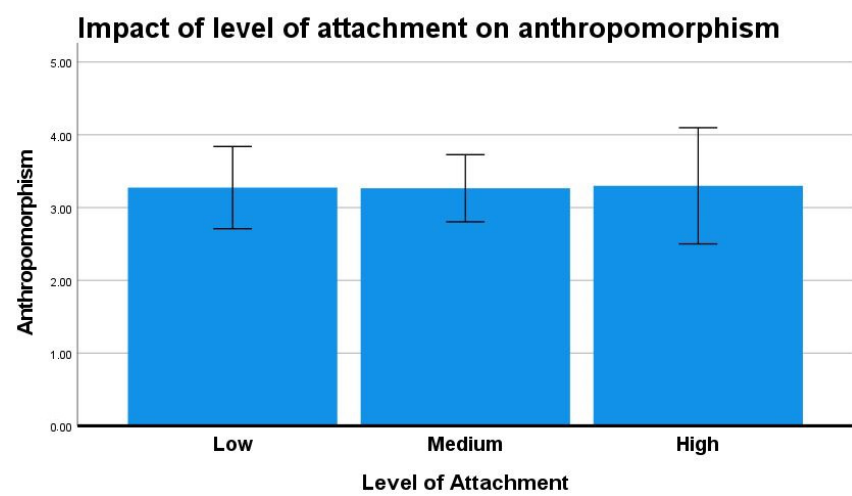
Figure 2. Participants’ tendency to anthropomorphise the robot from not at all (1) to very much (5), based on their level of attachment to the robot (low, medium, high).